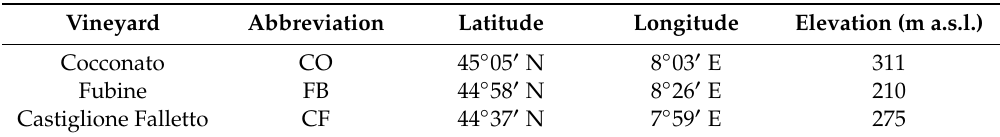
Table 2. Coordinates of the three experimental sites.